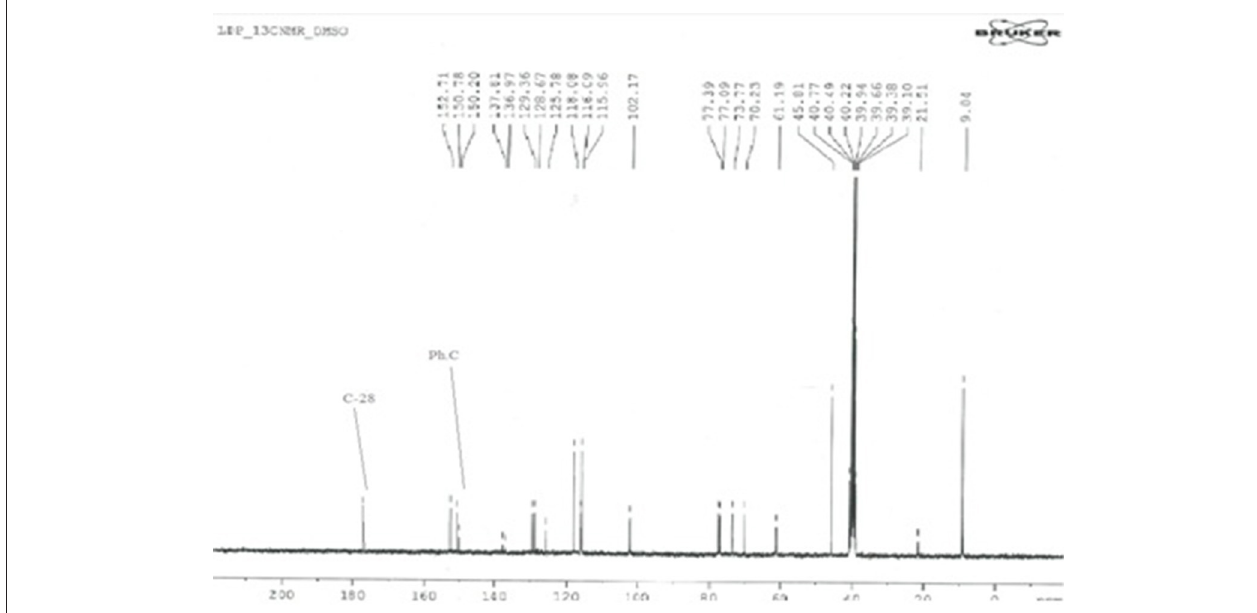
FIGURE 6 | 13 C-NMR Spectrum of diphenyl tin